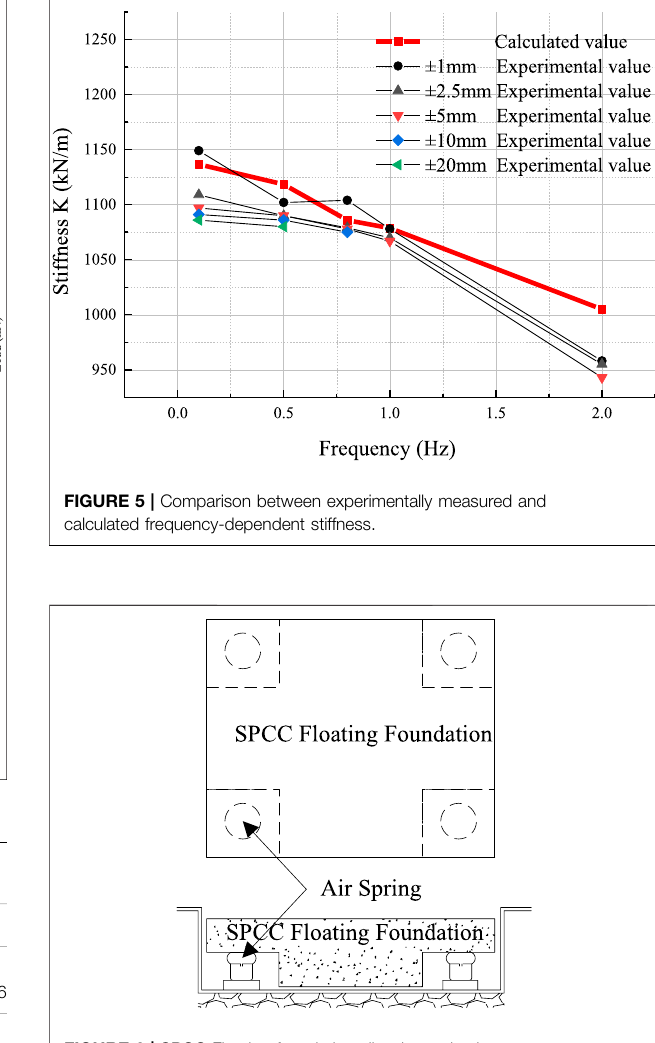
FIGURE 6 | SPCC Floating foundation vibration reduction